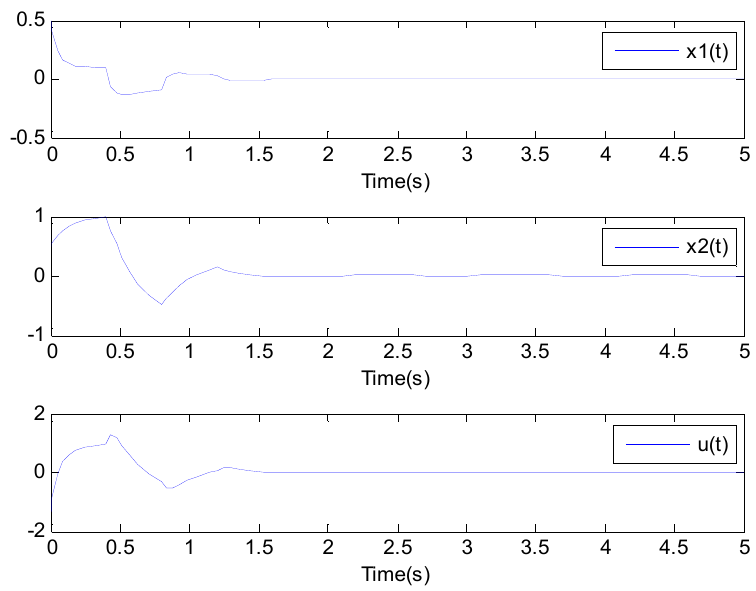
Figure 10. The state variables evolutions x 1 ( t ) , x 2 ( t ) and the controller u ( t ) .